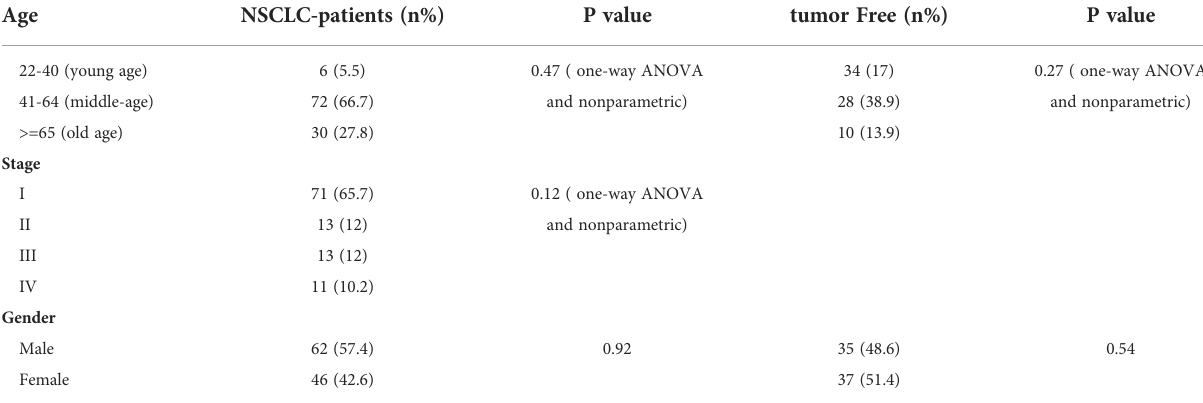
TABLE 1 Non-small cell lung cancer patient samples.